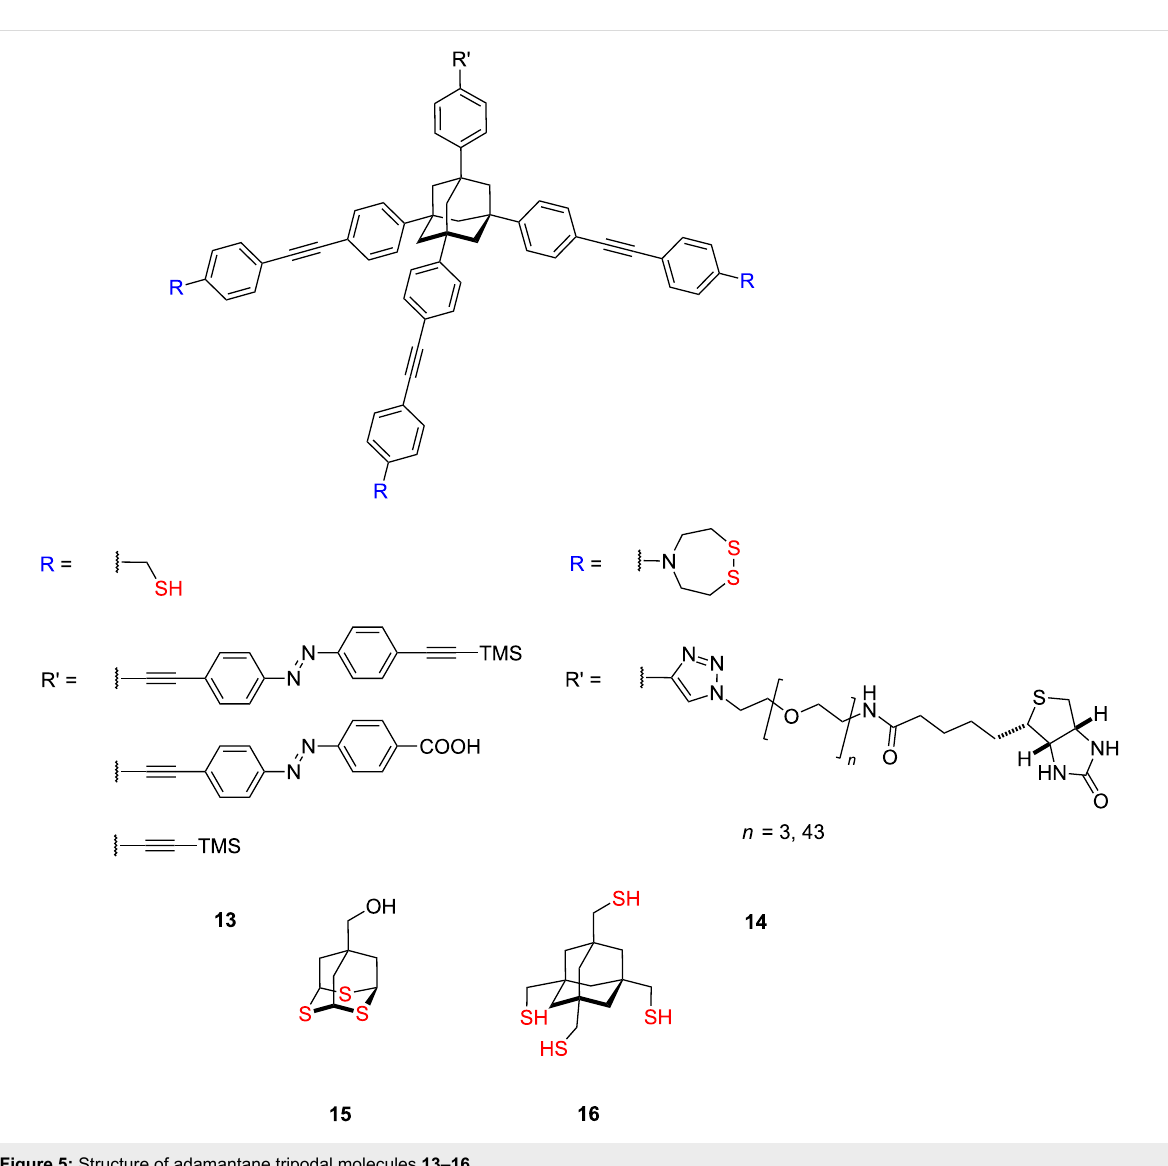
Figure 5: Structure of adamantane tripodal molecules 13–16